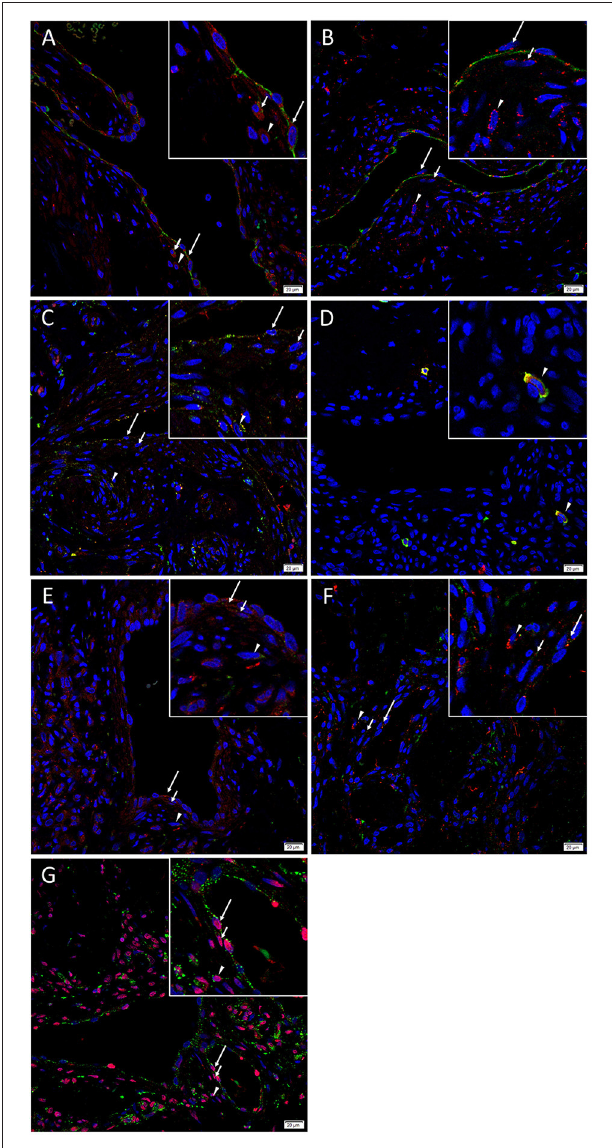
FIGURE 4 | Representative immunofluorescence images of arterio-venous malformation tissue samples. Immunofluorescence staining showed expression of cathepsin B ( A , red) and cathepsin D ( B , red) on the CD31 + endothelium ( A,B , green, long arrows ) and media ( short arrows ) of the lesional vessels and cells within the stroma ( arrowheads ). Cathepsin B ( C , green) and cathepsin D ( C , red) were expressed on the endothelium ( long arrows ) and media ( short arrows ) of the lesional vessels and cells within and stroma ( arrowheads ). Cathepsin G ( D , red) was expressed on the chymase + ( D , green) mast cells within the stroma ( arrowheads ). Cathepsin B ( E , red), and cathepsin D ( F , red) were expressed on the OCT4 + ( E , F , green) endothelium ( long arrows ) and media ( short arrows ) of the lesional vessels and cells within the stroma ( arrowheads ). Cathepsin B ( G , green) was expressed on the SOX2 + ( G , red) endothelium ( long arrows ) and media ( short arrows ) of the lesional vessels and cells within the stroma ( arrowheads ). Cell nuclei were counterstained with 4 ′ ,6-diamidino-2-phenylindole ( A – G , blue). Original magnification: 400x. The insets show enlarged views of the corresponding